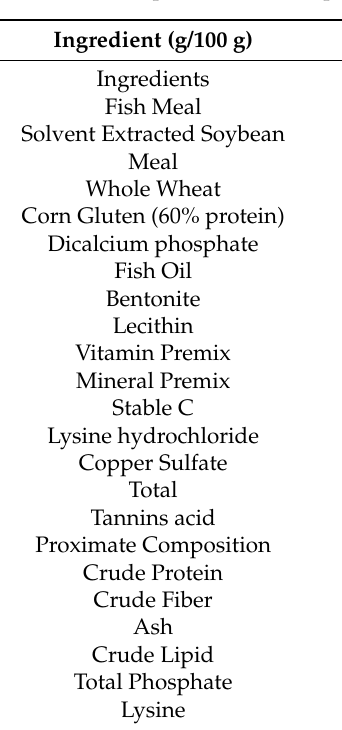
Table 1. The composition of the experimental